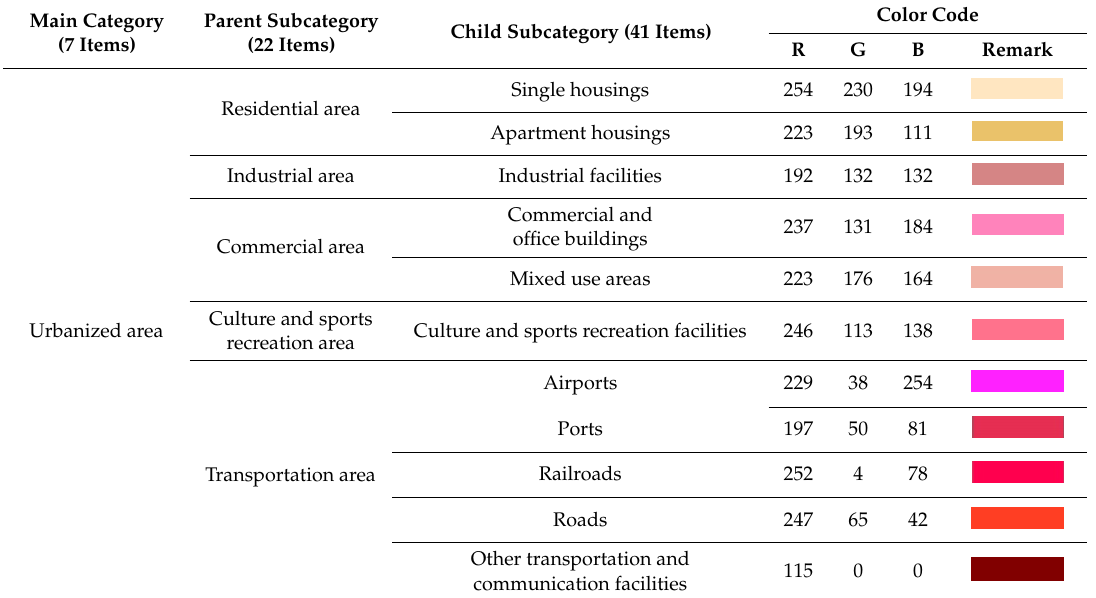
Table 1. Hierarchy of land cover categories and respective color codes (Environmental Geographic Information System (EGIS)).